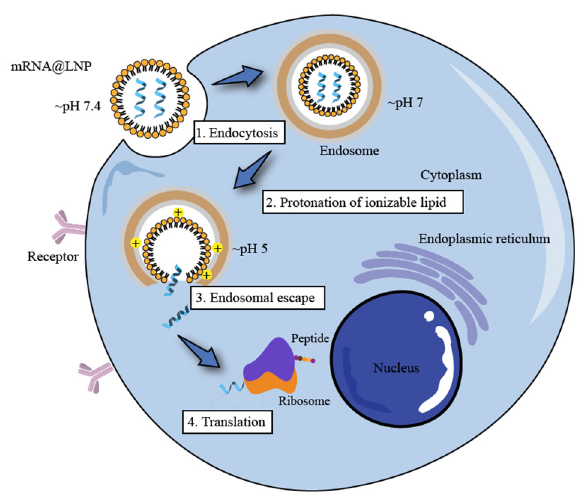
Figure 5. Delivery mechanism of LNP@mRNA.